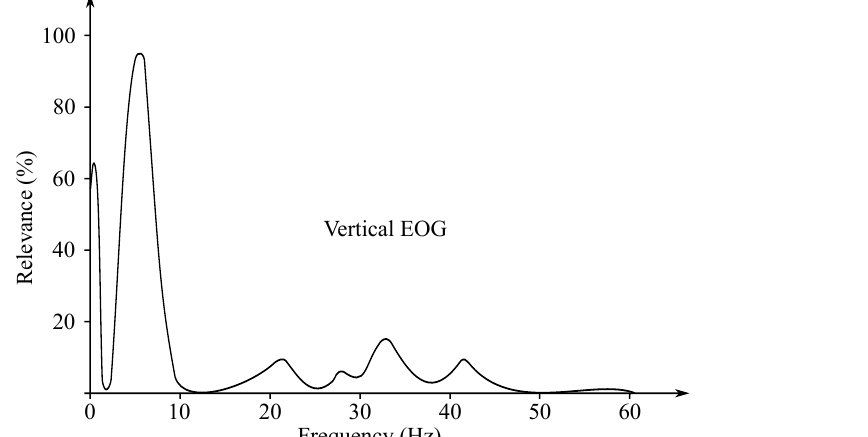
Figure 10. Sample EOG sisgnals.